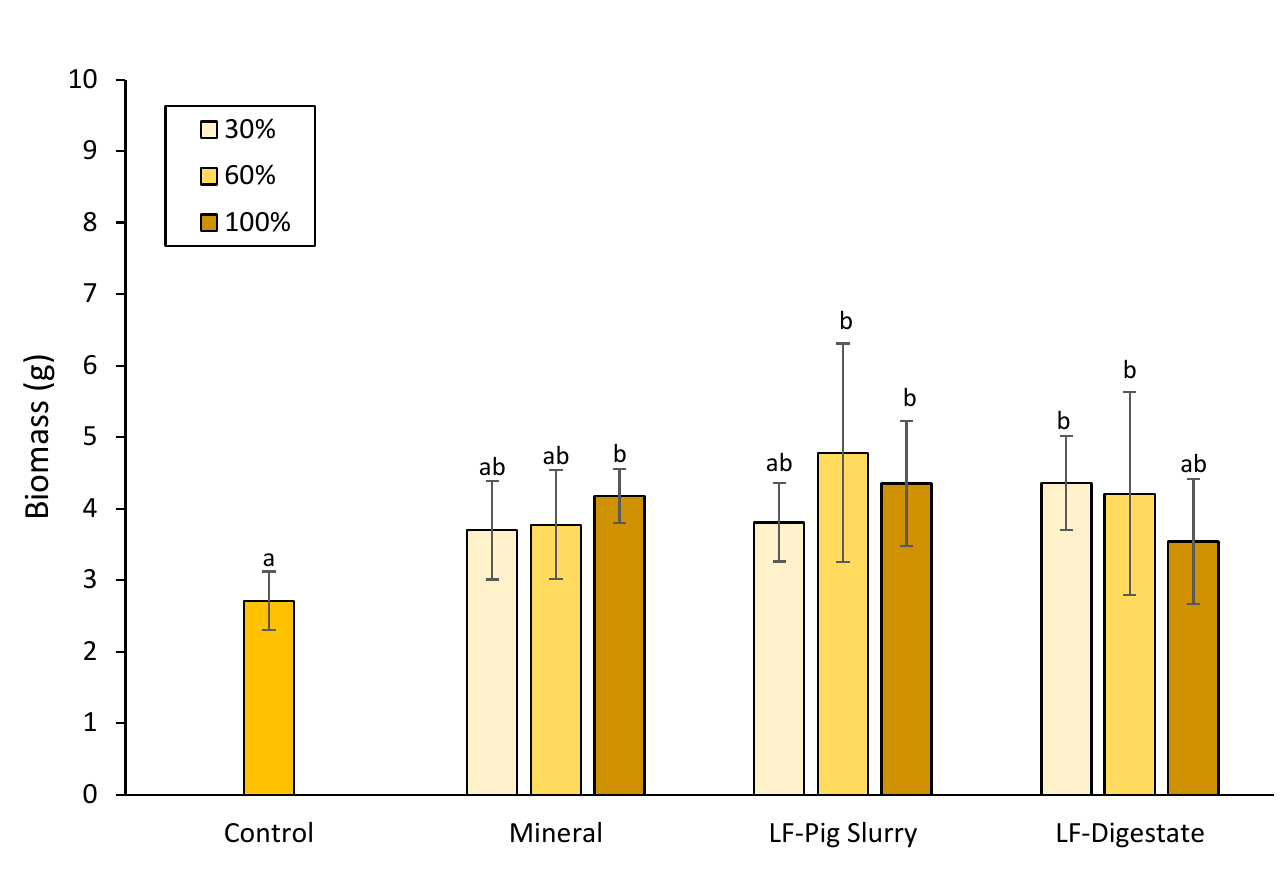
Figure 7. Dry weight (g) of barley plants under different treatments and applied application rates (30%, 60% and 100% of maximum permitted N application). Control, no fertilizer applied to plants. Each column represents the mean values ± SD. Columns with different letters were significantly different according to Duncan’s test ( p ≤ 0.05).